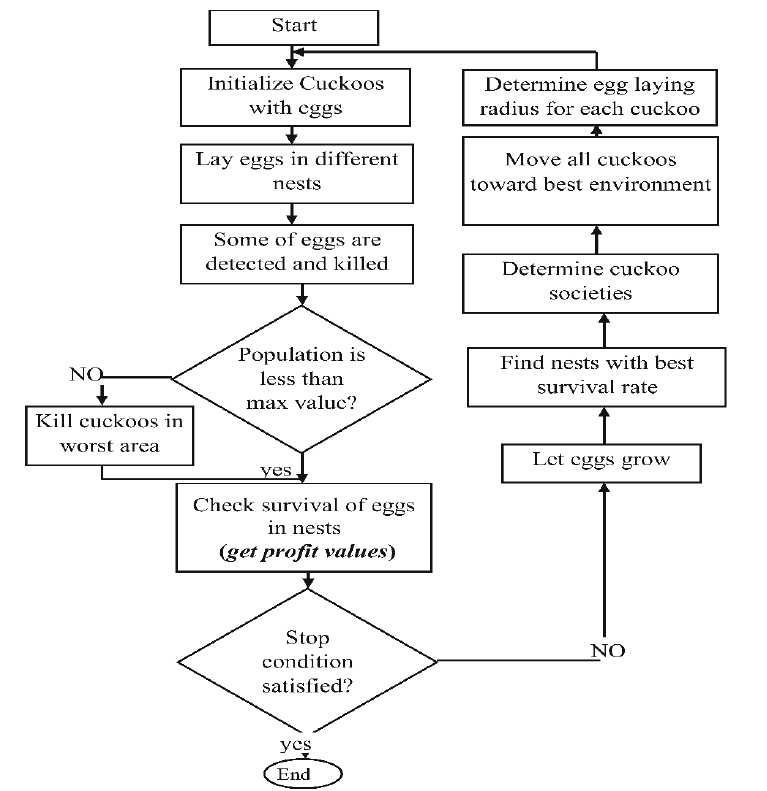
Fig. 1. The flow chart of the cuckoo optimization algorithm